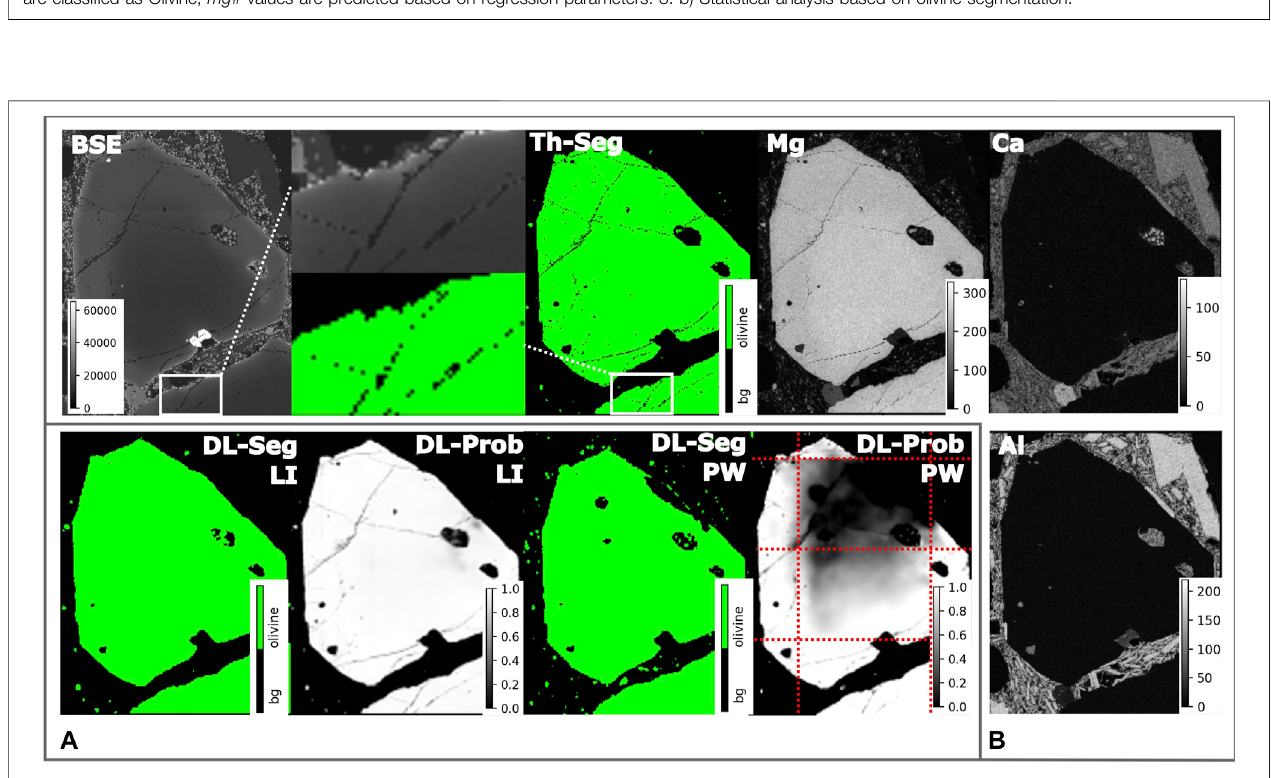
FIGURE3| This fi gureshows crystalfromthevalidationpartothe DL-Data ( Figure1 VI ).Panel (A) presents comparison betweenDLsegmentation usingthelarge image inference method described in Section 3.6.3 (LI) and patch wise segmentation result (PW). The DL-Seg sub fi gures shows the binary segmentation and the DL- Prob sub fi gures shows the inference result of the model before the application of the dl th . Red dashed lines represent the patch borders. Panel (B) is composed of the BSE image and the Ca, Al, Mg X-Ray elemental maps used for the threshold segmentation and the resulting Th-Seg binary segmented olivine map.